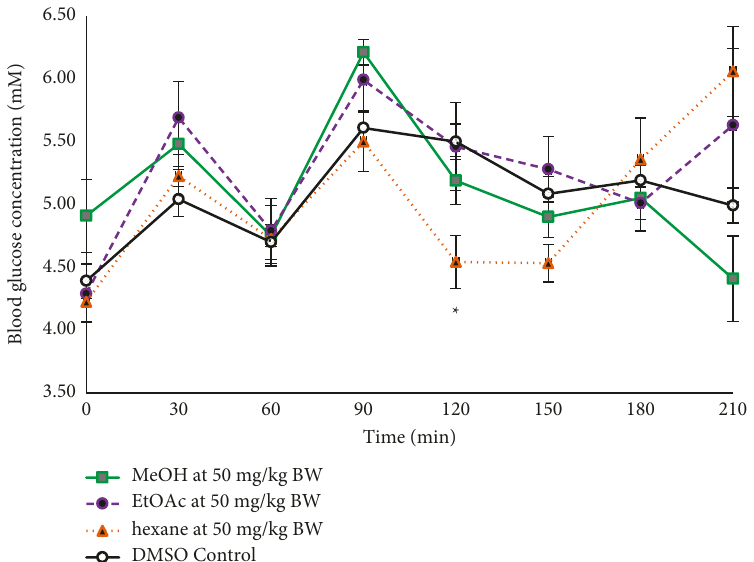
Figure 4: OGTTof crude extracts from Salvia serotina L. (chicken weed) when administered intravenously at 50mg/kg BW versus DMSO control ( n � 6). ∗ − p < 0 . 05. EtOAc – ethyl acetate and MeOH – methanol.